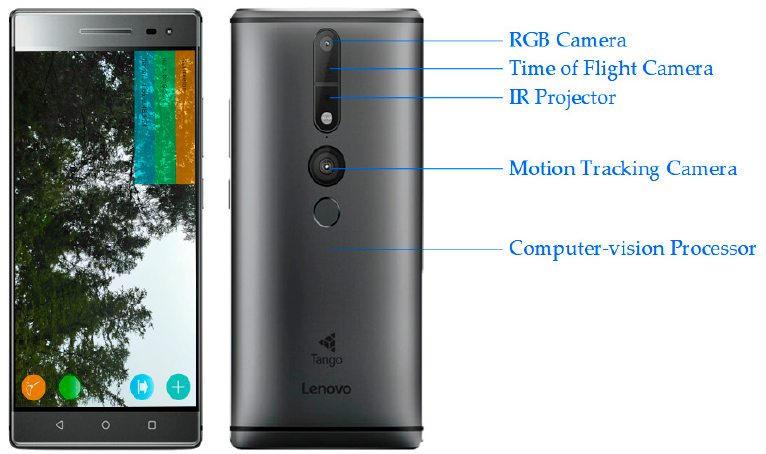
Figure 2. Structure of a smart phone (Lenovo Phab 2 Pro) with RGB-D SLAM.